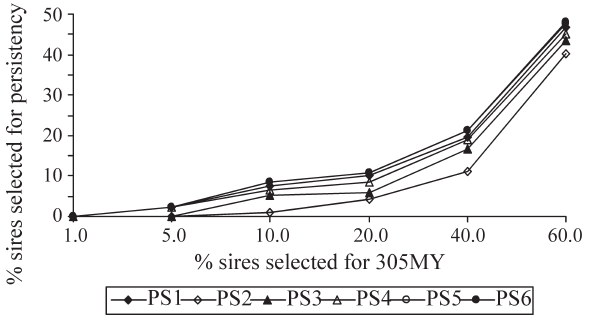
Figure 4 - Percentage of sires selected for persistency of lactation (PS